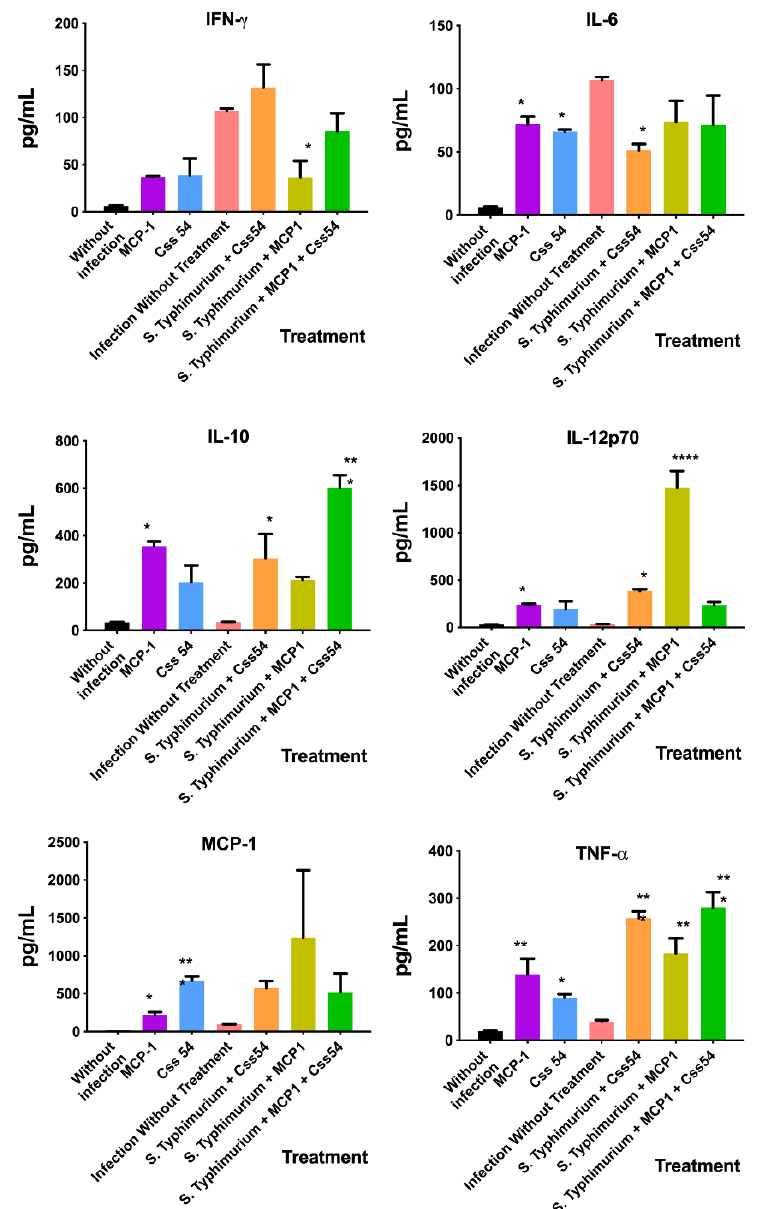
Figure 9. Cytokine expression was altered in mice treated with Css54 and MCP-1. Plasma from Balb/C mice after infection and treatment with Css54, MCP-1, and MCP-1 + Css54 was analyzed by flow cytometry at 100 µ L/min. Css54, MCP-1, and MCP-1 + Css54: 15 µ M; Infection without treat- ment: PBS. This figure shows the average and standard deviation of triplicates from two independent experiments (* p < 0.05; ** p < 0.01; **** p < 0.0001).